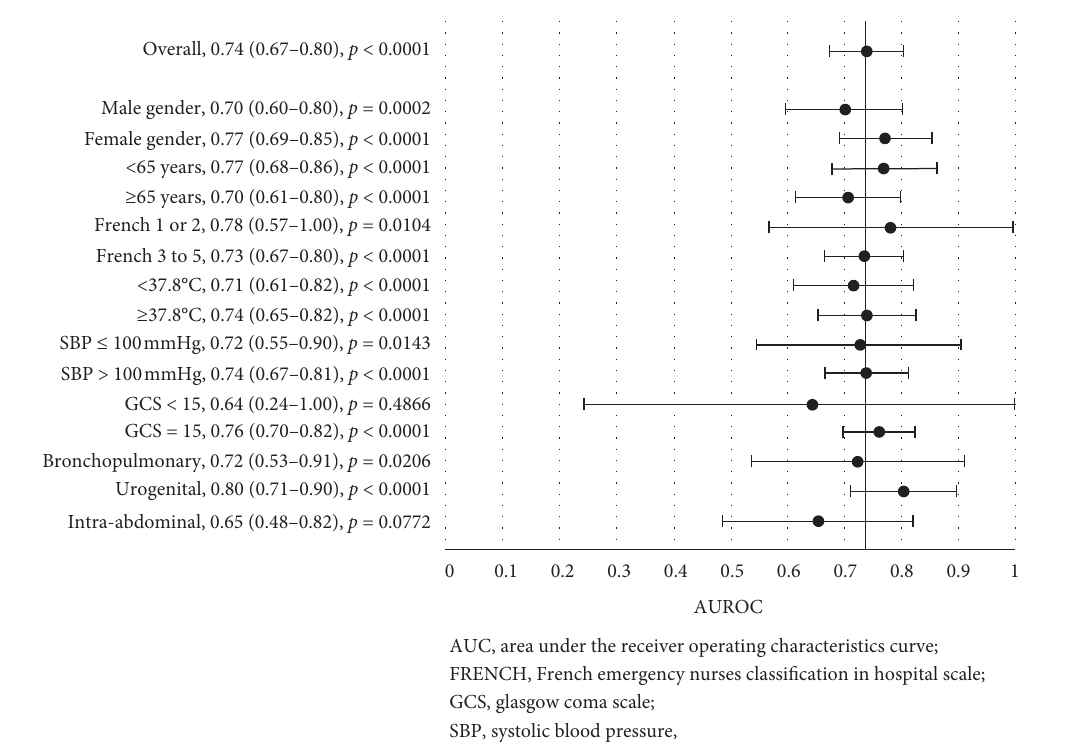
Figure 3: Forest plot of the area under the receiver operating characteristics curve for procalcitonin discrimination in bacteremia, stratified by different